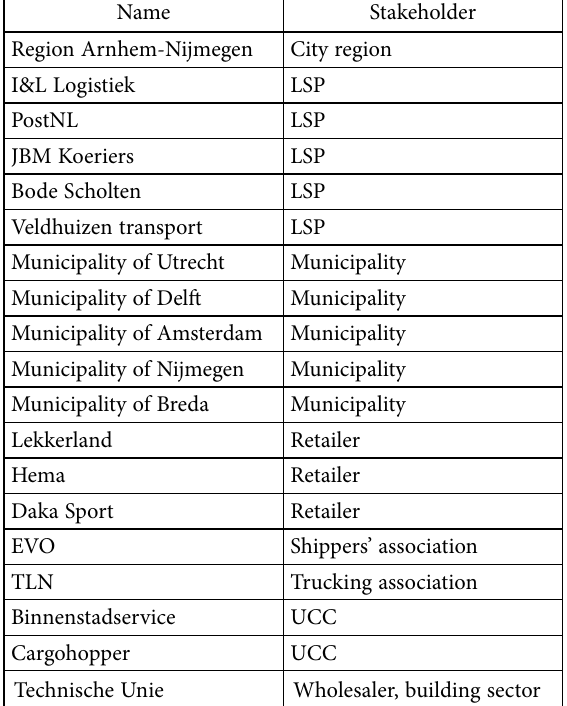
Table 2. P-set selection of respondents